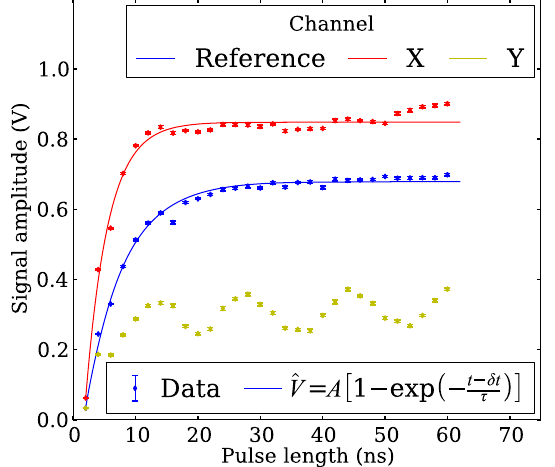
FIG. 10. Signal frequency measured every five samples along the length of 40 ns long